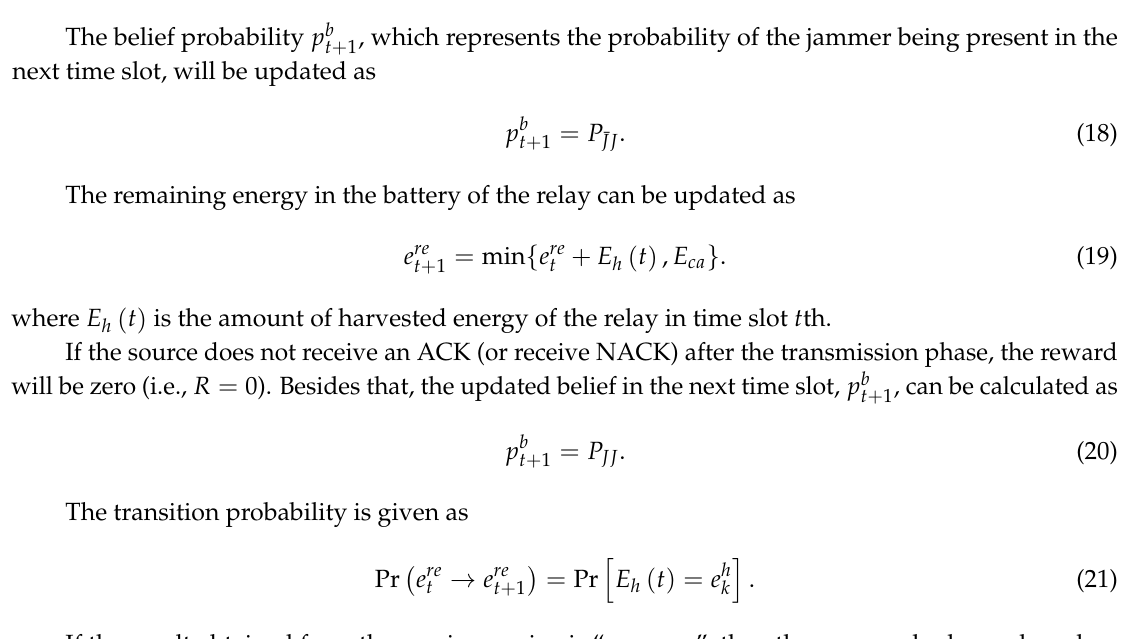
Figure 4. Flowchart of the proposed